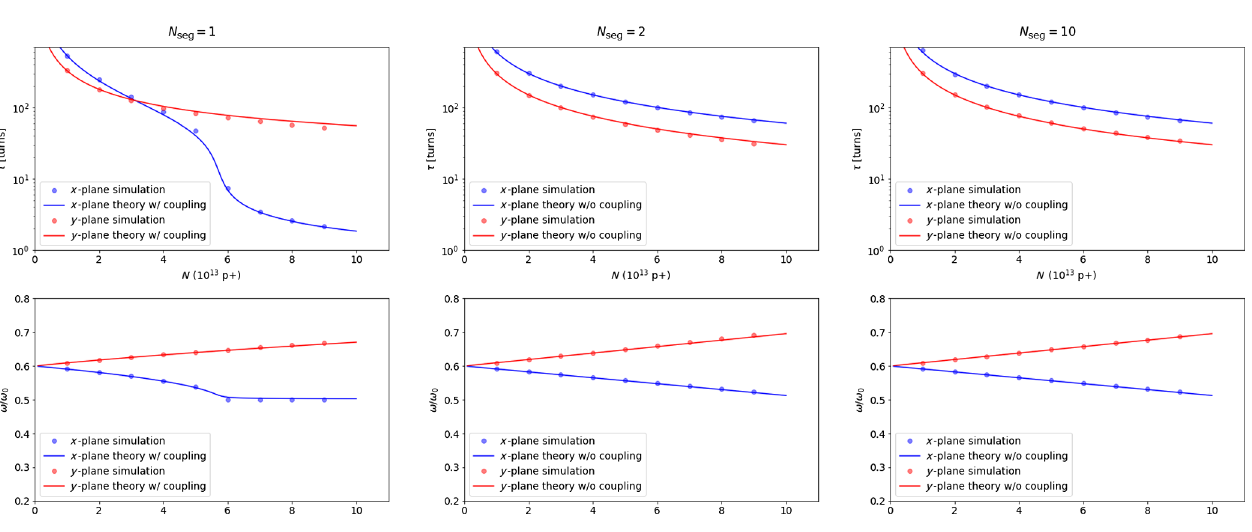
FIG. 1. Updated comparison between tracking simulations and theory with coupling (for N N 2 and N 10 with equally spaced kicks). The rise time versus beam intensity is shown at the top, while the real part of the seg ¼ seg ¼ tune shift versus beam intensity is shown at the